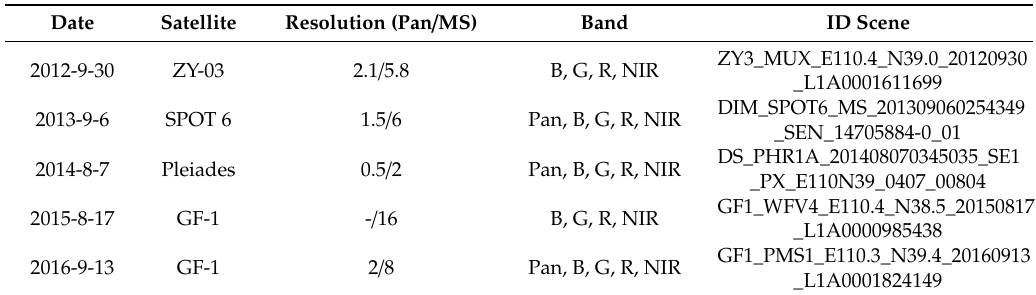
Table 1. List of high-resolution images where ZY-03 and GF-1 represent the Chinese Ziyuan 3 and Gaofeng 1 satellites. Pan refers to the panchromatic band, MS refers to the multispectral band, and B, G, R, and NIR refer to blue, green, red, and near-infrared, respectively. “-” represents null.